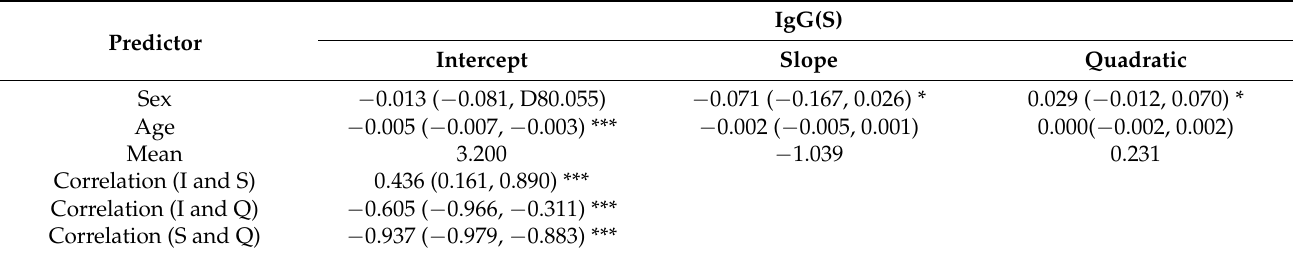
Table 3. Estimated parameters from the latent growth curve